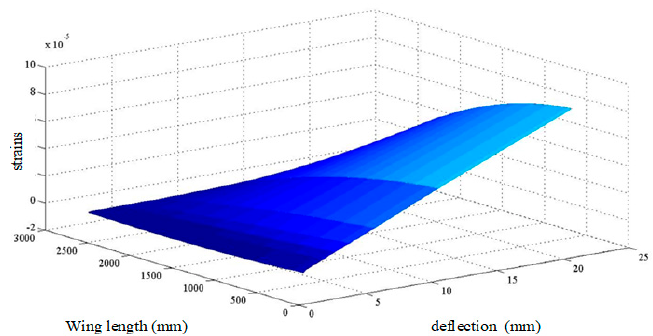
Figure 13. Change of strain with time at the point of fiber Bragg grating.